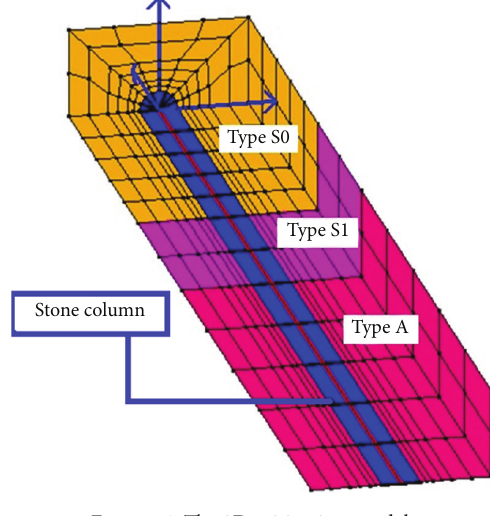
Figure 4: The 3D mitigation model.